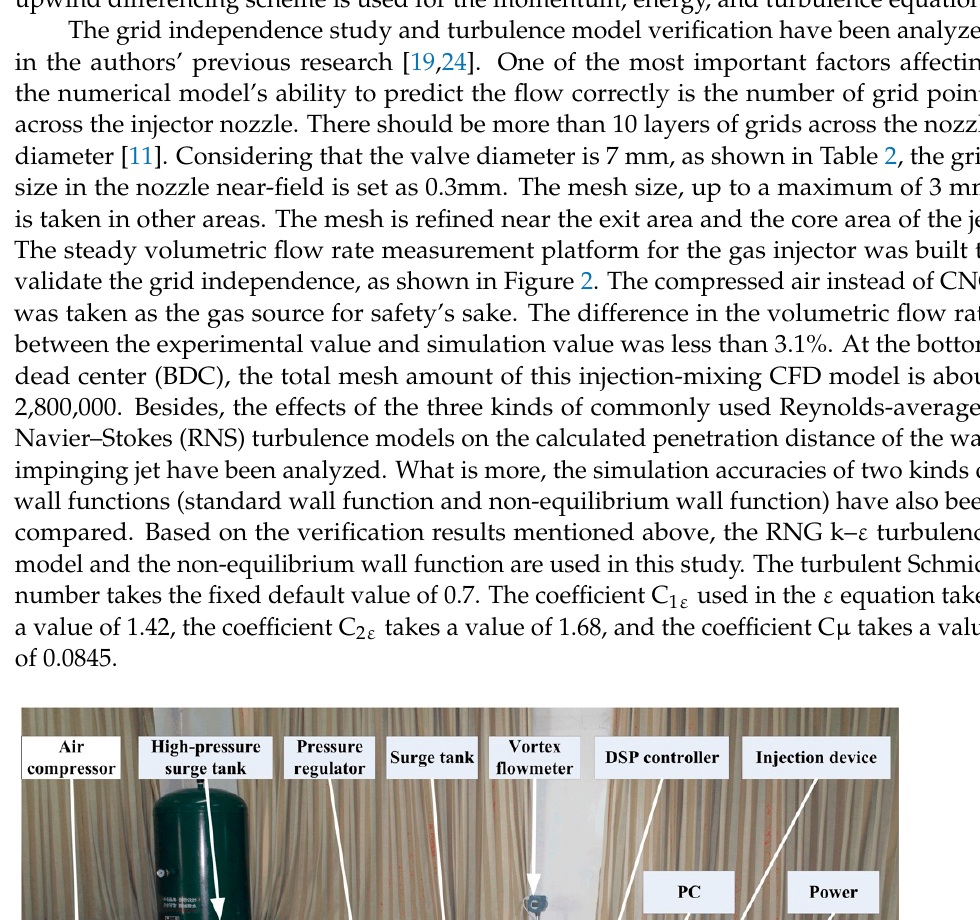
Table 2. Parameters of each case.